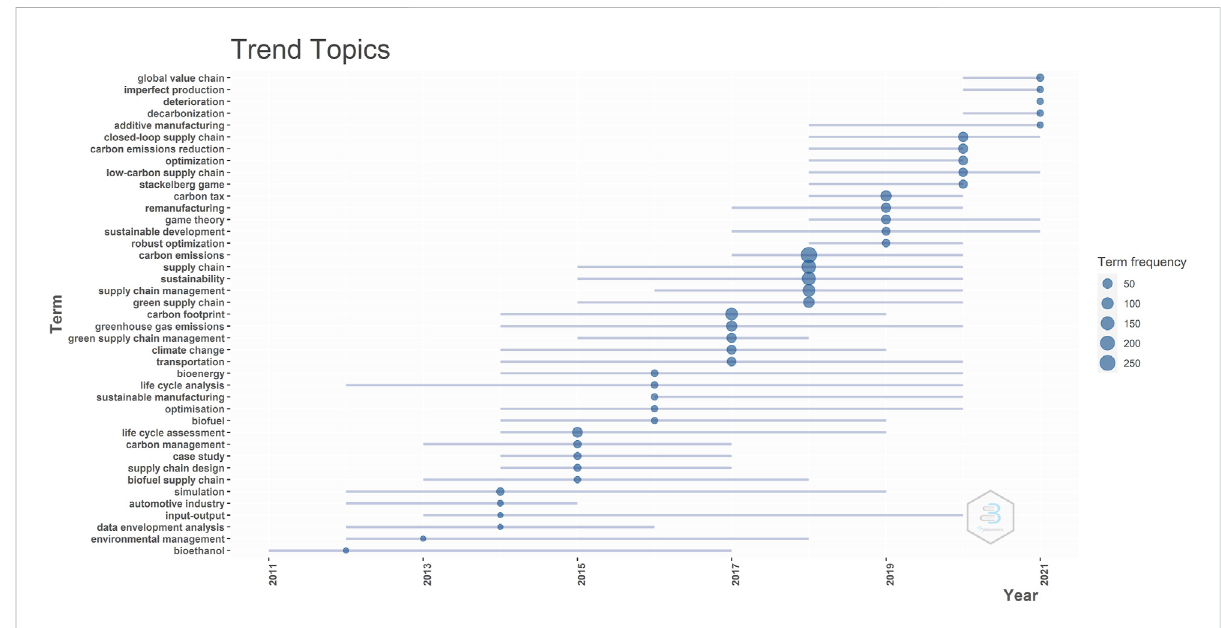
FIGURE 6 The trend topics analysis in authors ’